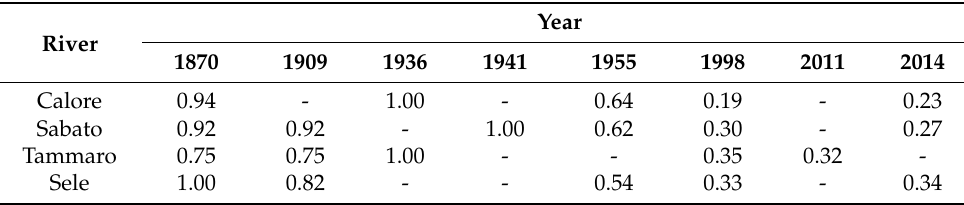
Table 5. W/W max values of the investigated rivers in the considered dates.